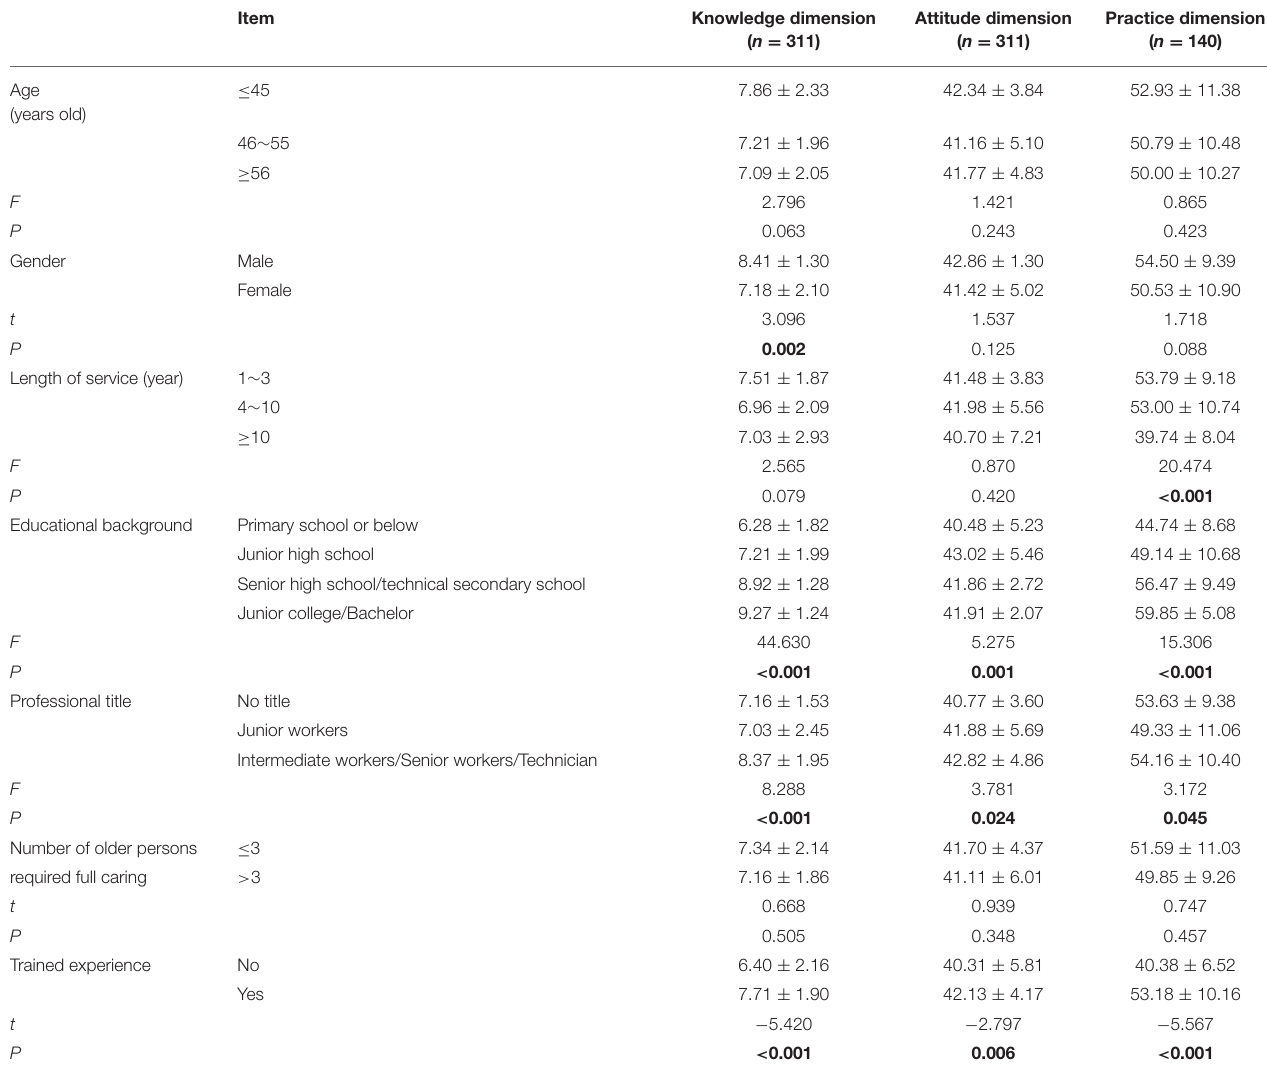
TABLE 4 | Comparison of KAP scores of physical restraint among nursing staff with different characteristics (score, x ± s). Item Knowledge dimension